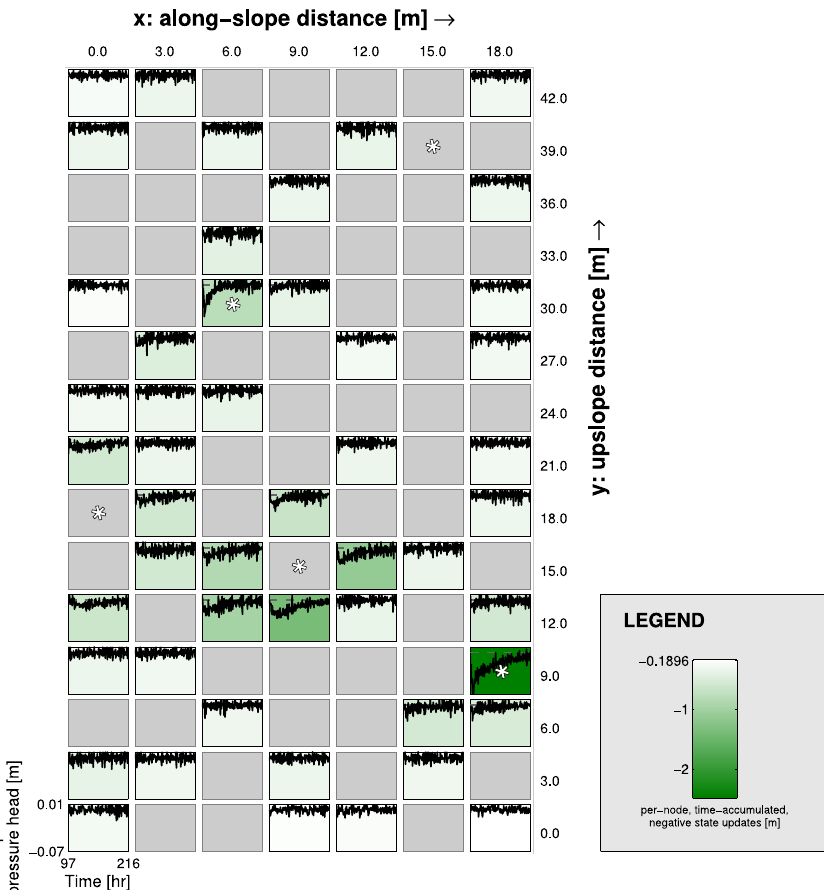
Fig. 10. SODA (reduced and perturbed data set): pressure head state updates in space and time. These state updates are associated with the Pareto-optimal parameter combination log 10 (r sink ) ≈ − 2 . 13; log 10 (K s ) ≈ − 0 . 46. Where pressure head observations were available, the figure contains a subplot showing a time series of state updates at the soil–bedrock interface (black line) for t = 97–216h; the other nodes have been grayed out. Horizontal dashed lines represent zero-updates (no adjustment). To ease interpretation of the updating pattern, each subplot was assigned a background color that visually shows the magnitude of cumulative negative updating. Greener backgrounds mean stronger over-estimation (i.e.the simplified model’s a priori value is too wet with respect to the artificial measurements). This figure uses a color scheme that is different from that of Fig. 5 to emphasize the difference in interpretation between model-observation residuals on the one hand and state updates on the other. The locations of sink hotspots as used in the reference model (but not the simplified model) are indicated with asterisks.